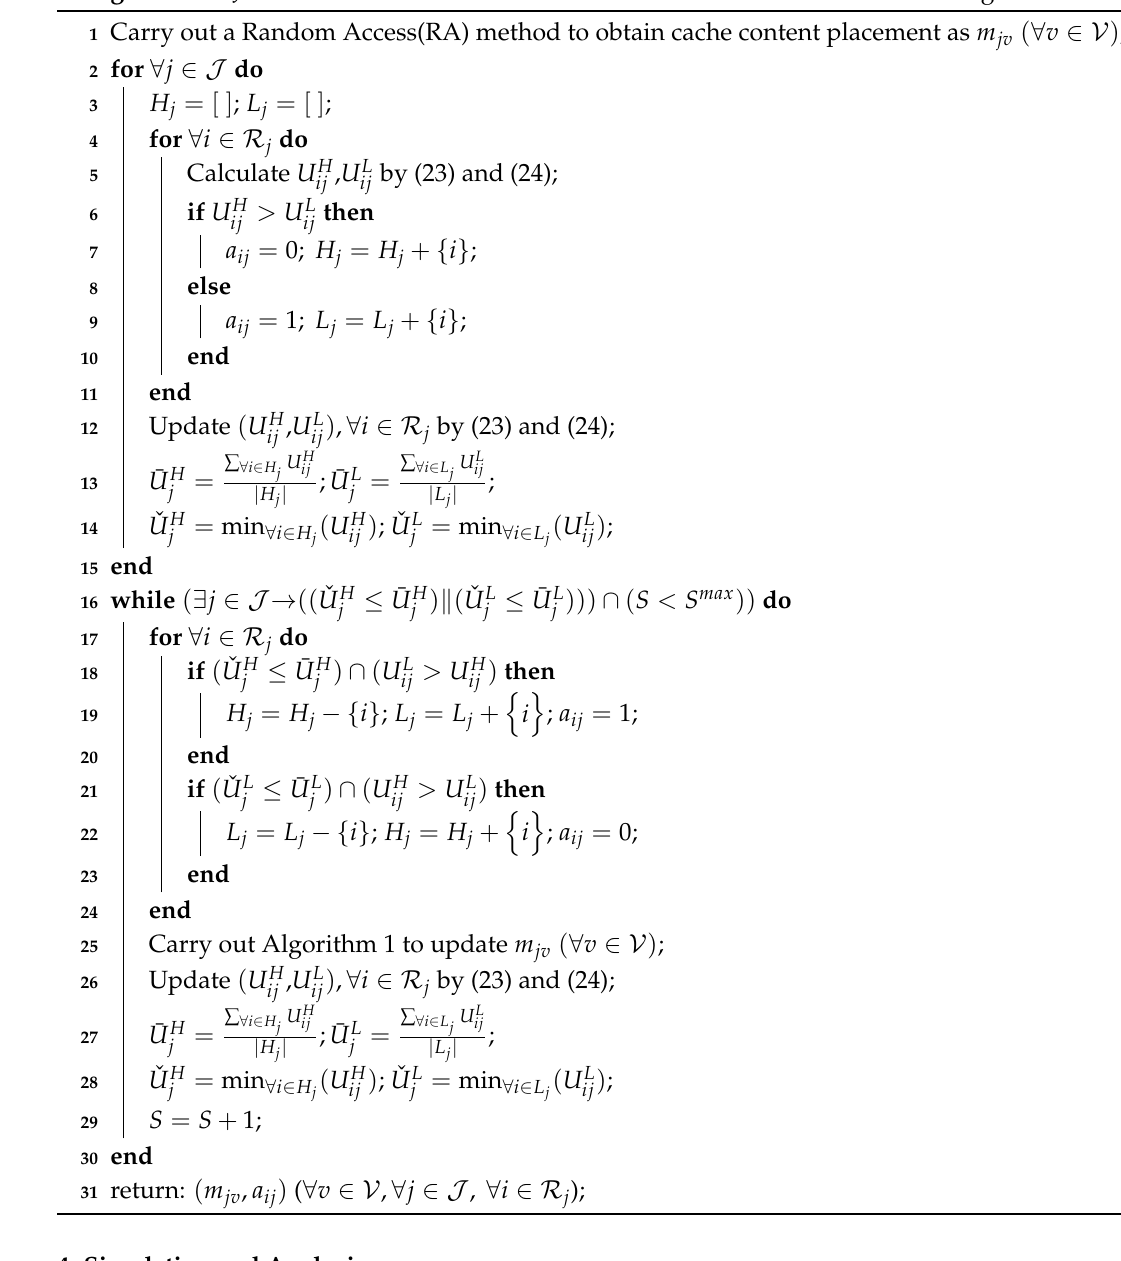
Algorithm 2: Joint Solution on Cache Content Placement and User Task